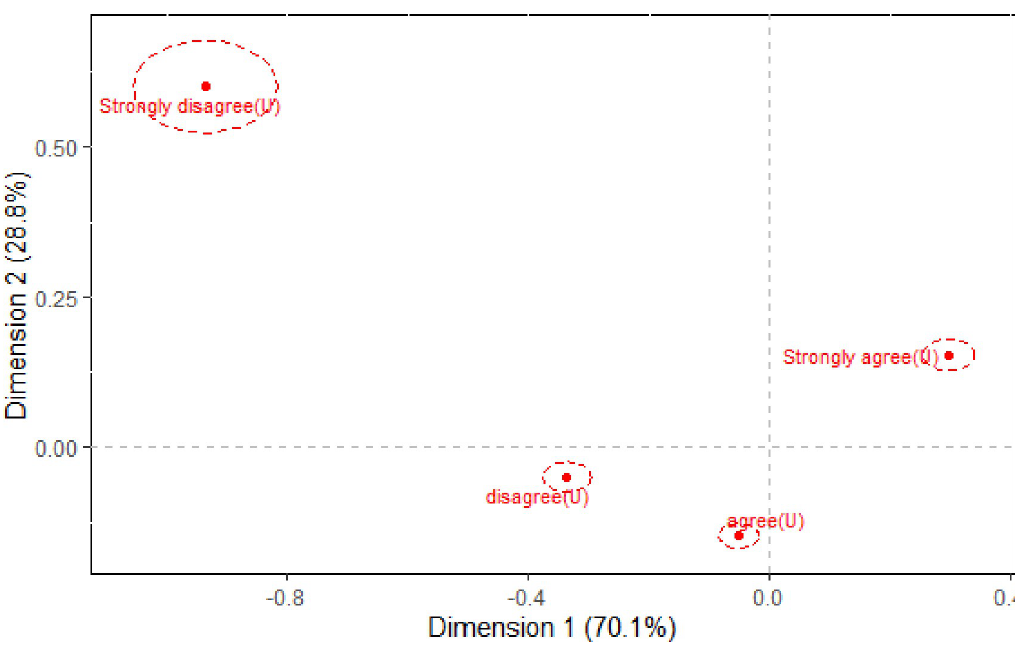
Fig 2. 95% Confidence ellipses for the Utility (U) variable of Table 1.